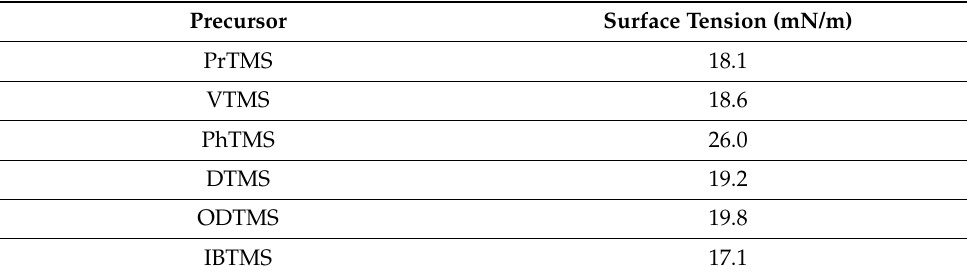
Table 2. Calculated surface tension from HSPiP software